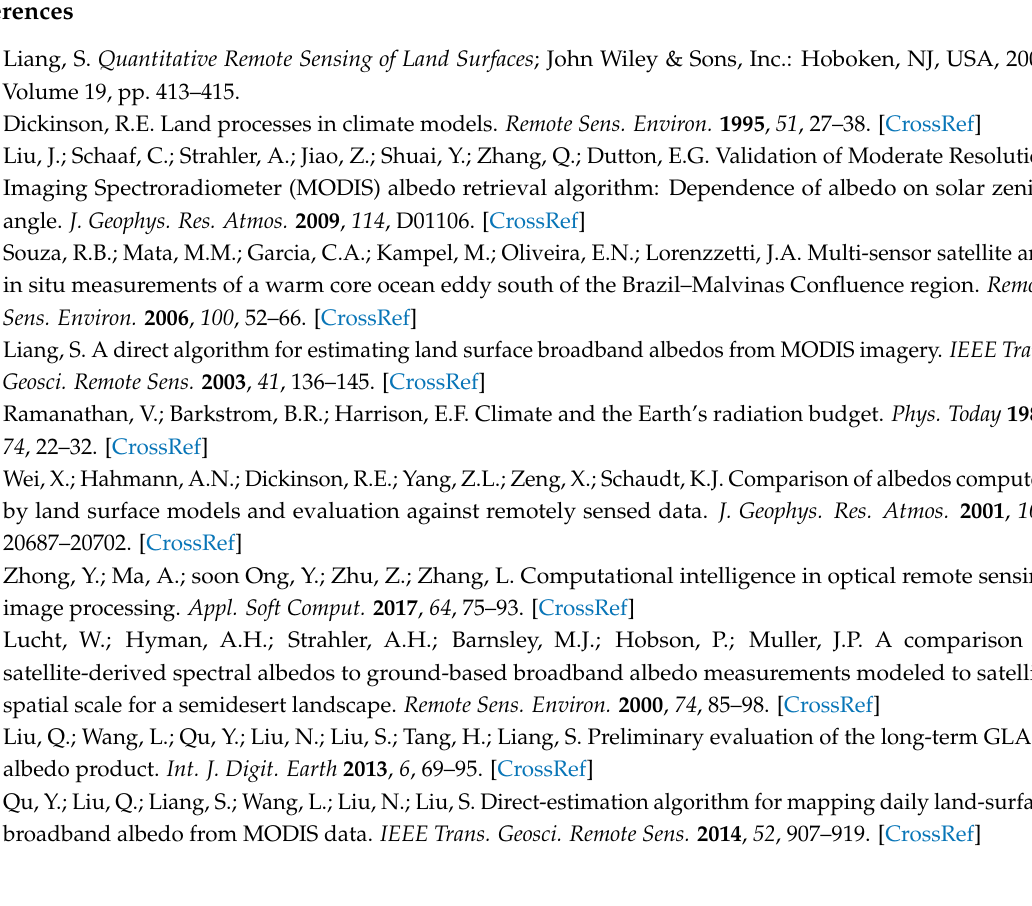
Figure A3. ( a – f ) The multi-scale validation results based on the aggregated calibrated HJ albedo for MCD43A3 (V006) (left), GLASS (middle) and MuSyQ (right). N indicates the number of the data points.